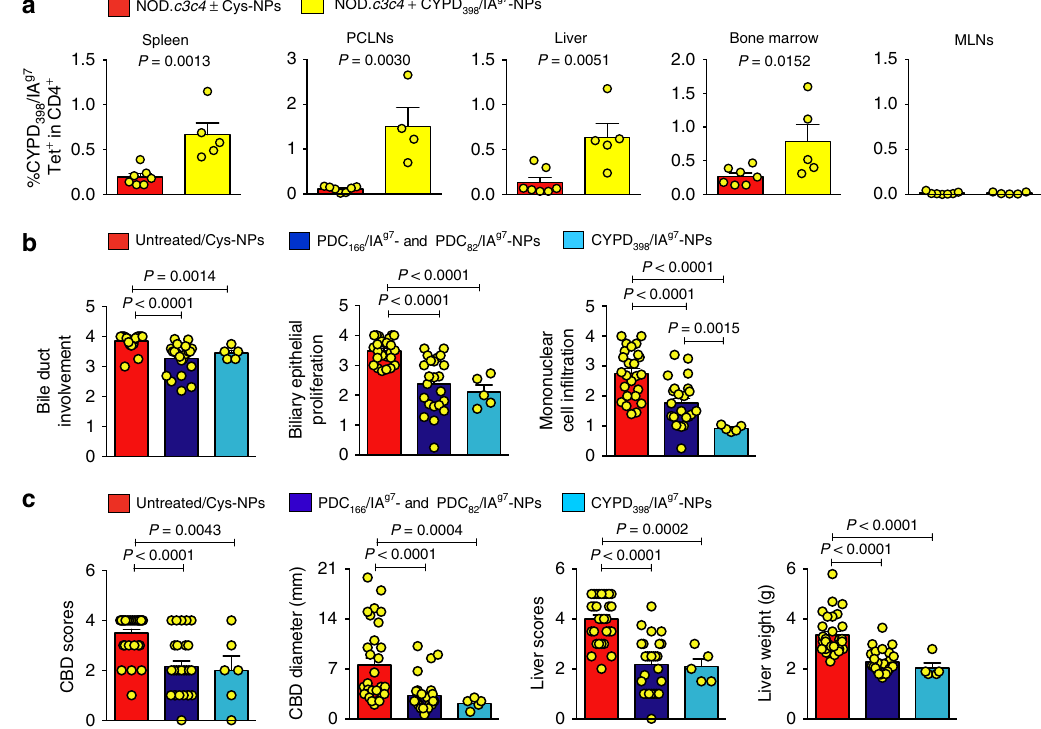
Fig. 9 AIH-relevant pMHCII-NPs are as ef fi cient as PBC-relevant pMHCII-NPs to blunt PBC in NOD. c3c4 mice. a Percentage of tetramer + cells in untreated/Cys-NP-treated ( n = 7), or CYPD 398 – 412 /IA g7 -NP-treated mice ( n = 5). b and c Average microscopic ( b ) or macroscopic ( c ) liver scores for the mice treated with PDC 166 – 181 /IA g7 -NPs or PDC 82 – 96 /IA g7 -NPs ( n = 23, fi ve experiments for b and n = 27, six experiments for c ) vs. CYPD 398 – 412 /IA g7 -NPs ( n = 5, one experiment), as compared to untreated/Cys-NP-treated mice ( n = 20, six experiments for b and n = 30, seven experiments for c ). Data correspond to the mean ± SEM. P values were calculated via Mann – Whitney